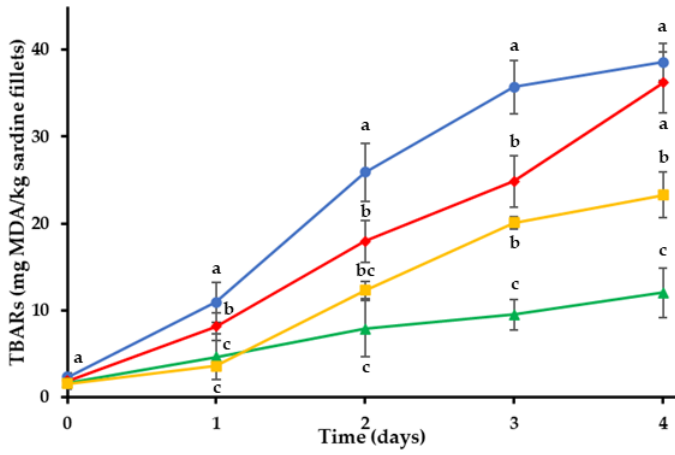
Figure 1. Oxidation values of sardine fillets with edible coatings during storage at 4 °C. ( ● ) C: control-uncoated fillets; ( ♦ ) H: hydrogel coating; ( ▲ ) O: oleogel coating; ( ■ ) BG: bigel coating. a – c Different letters in the same day indicate significant differences ( p < 0.05).